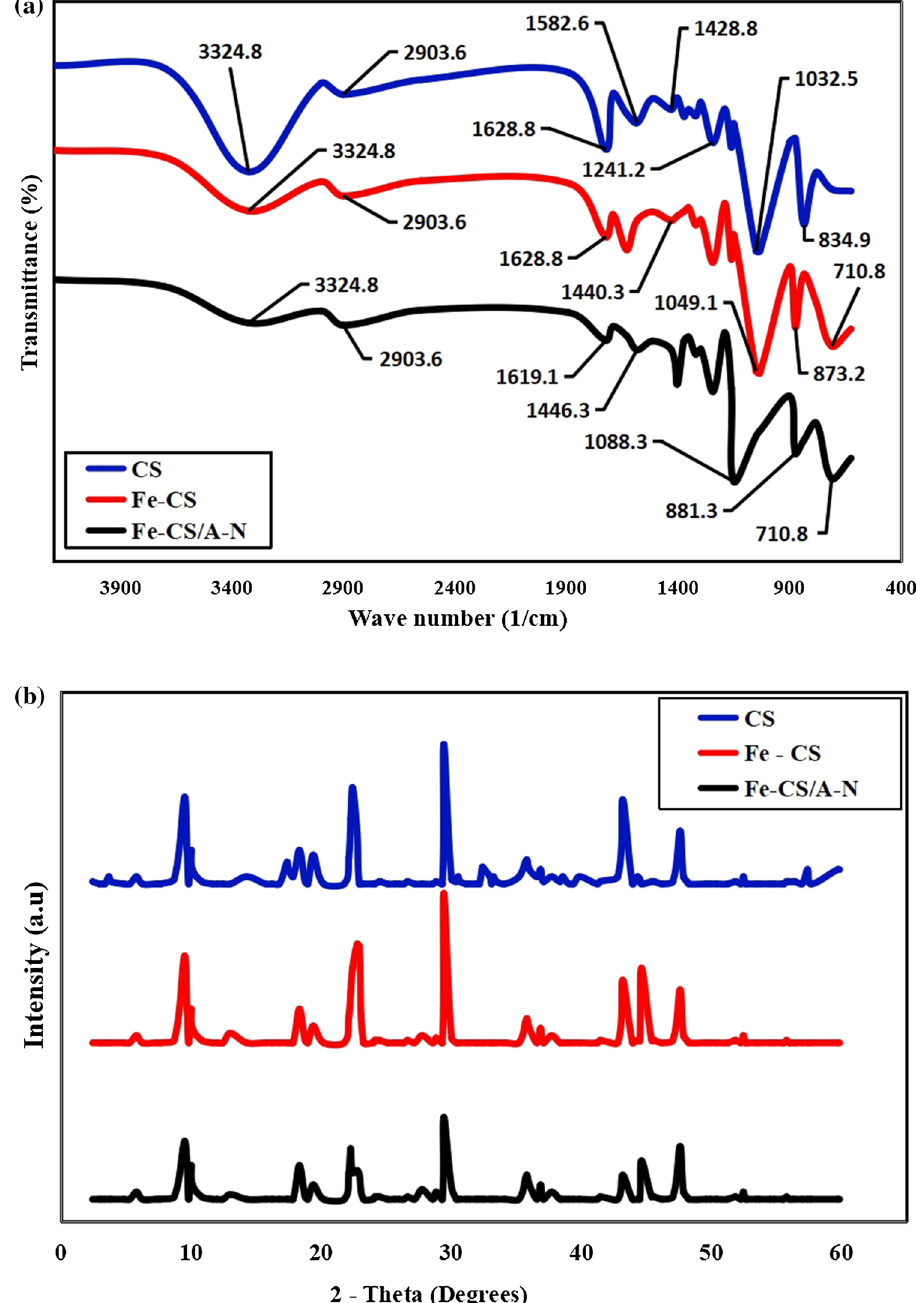
Fig. 2 a FTIR spectra and